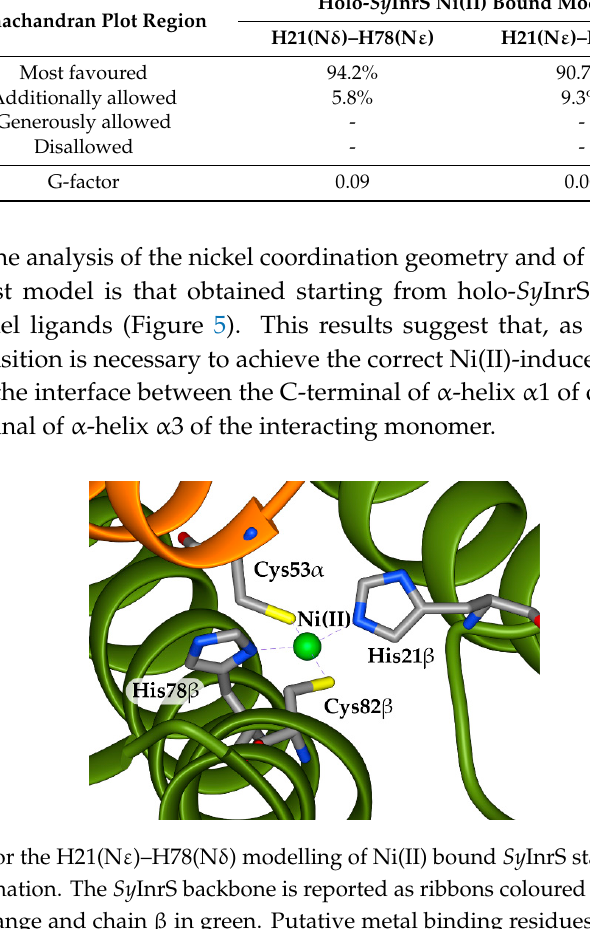
Table 4. Structural analysis of the models of Sy InrS binding nickel in square planar coordination